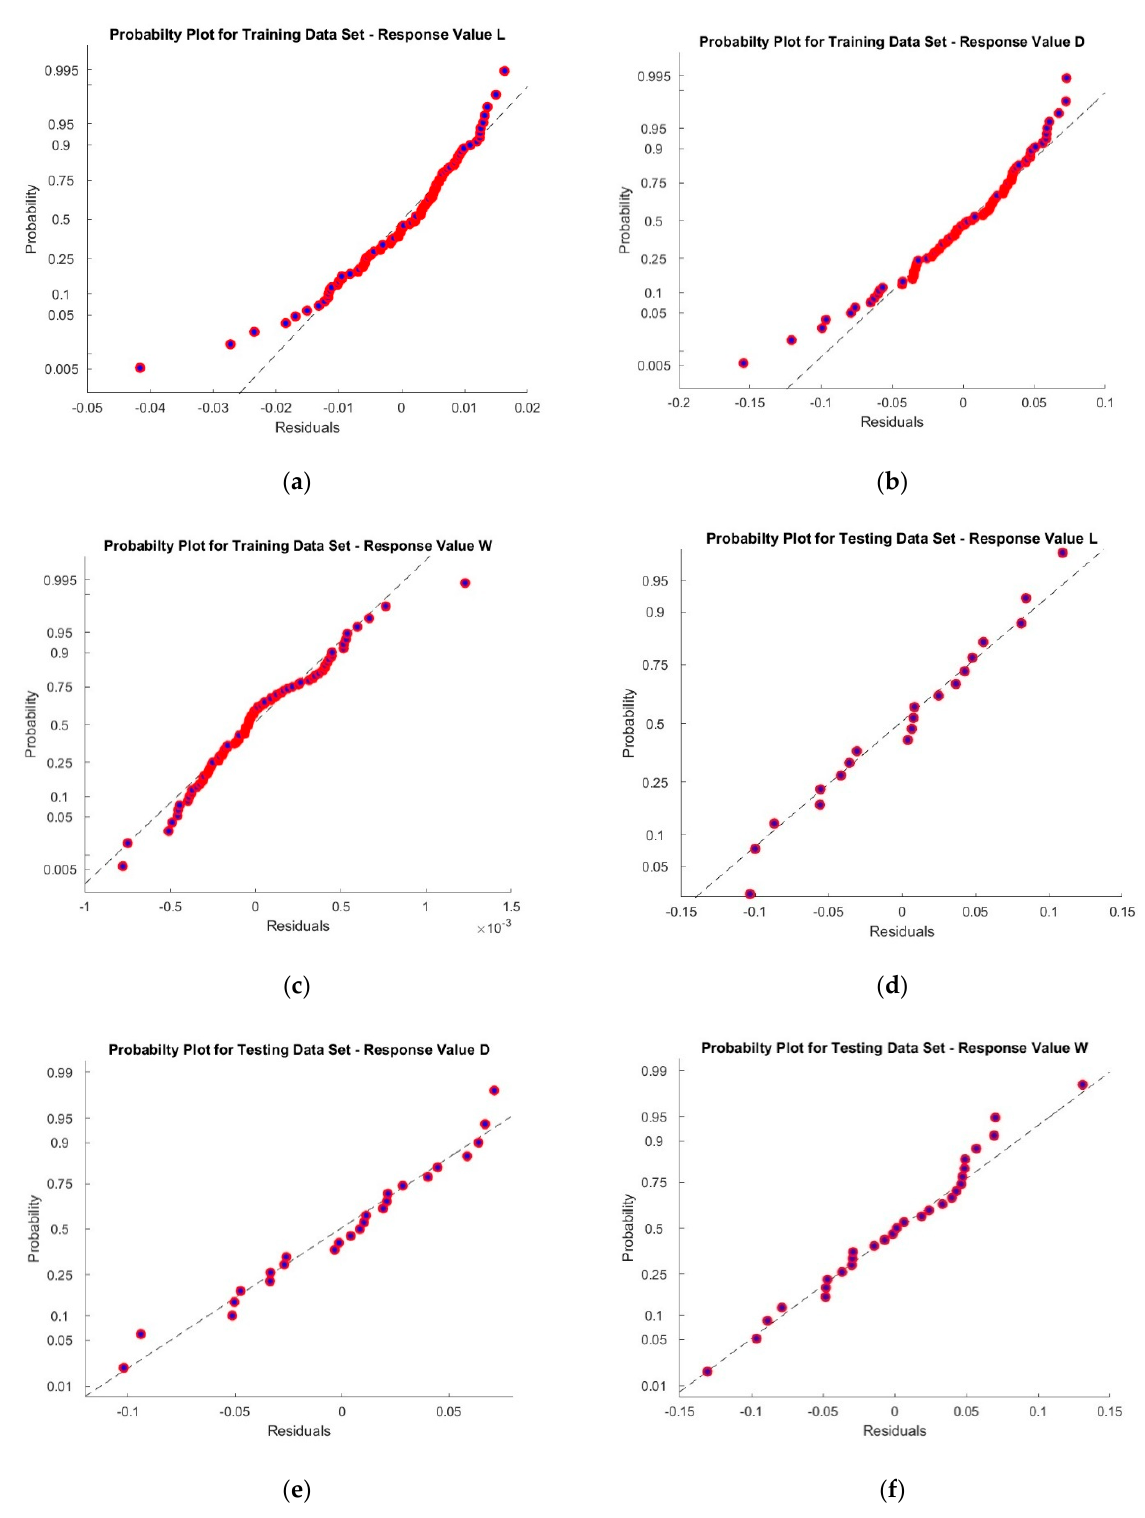
Figure 7. Probability Plot for ( a ) Training Dataset-Response L; ( b ) Training Dataset-Response D; ( c ) Training Dataset-Response W; ( d ) Testing Dataset-Response L; ( e ) Testing Dataset-Response D; ( f ) Testing Dataset-Response W.